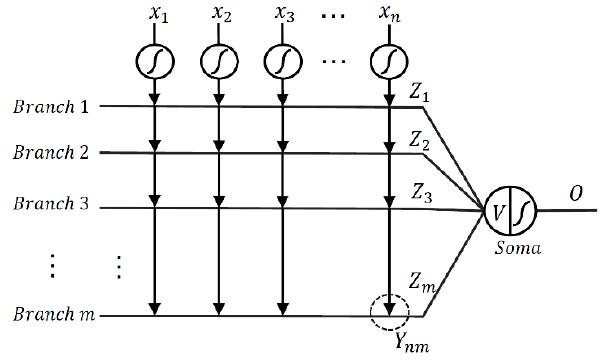
Figure 1. Structure of the dendritic neuron model (DNM).